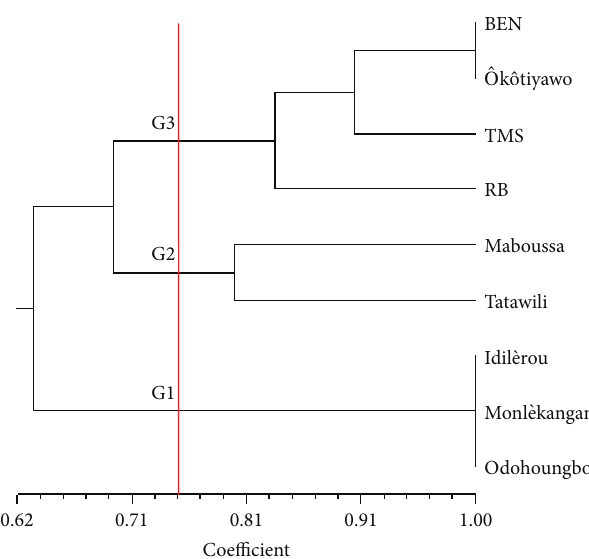
Figure 2: Dendrogram showing the classification of the 9 elite cultivars into three